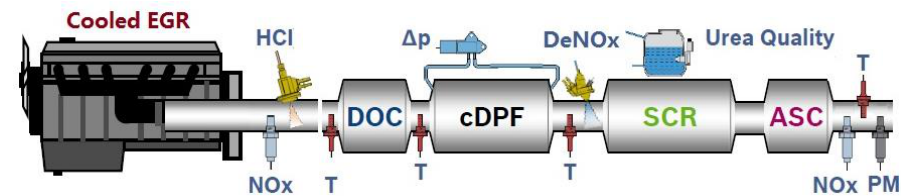
Figure 4. Diesel exhaust aftertreatment system.